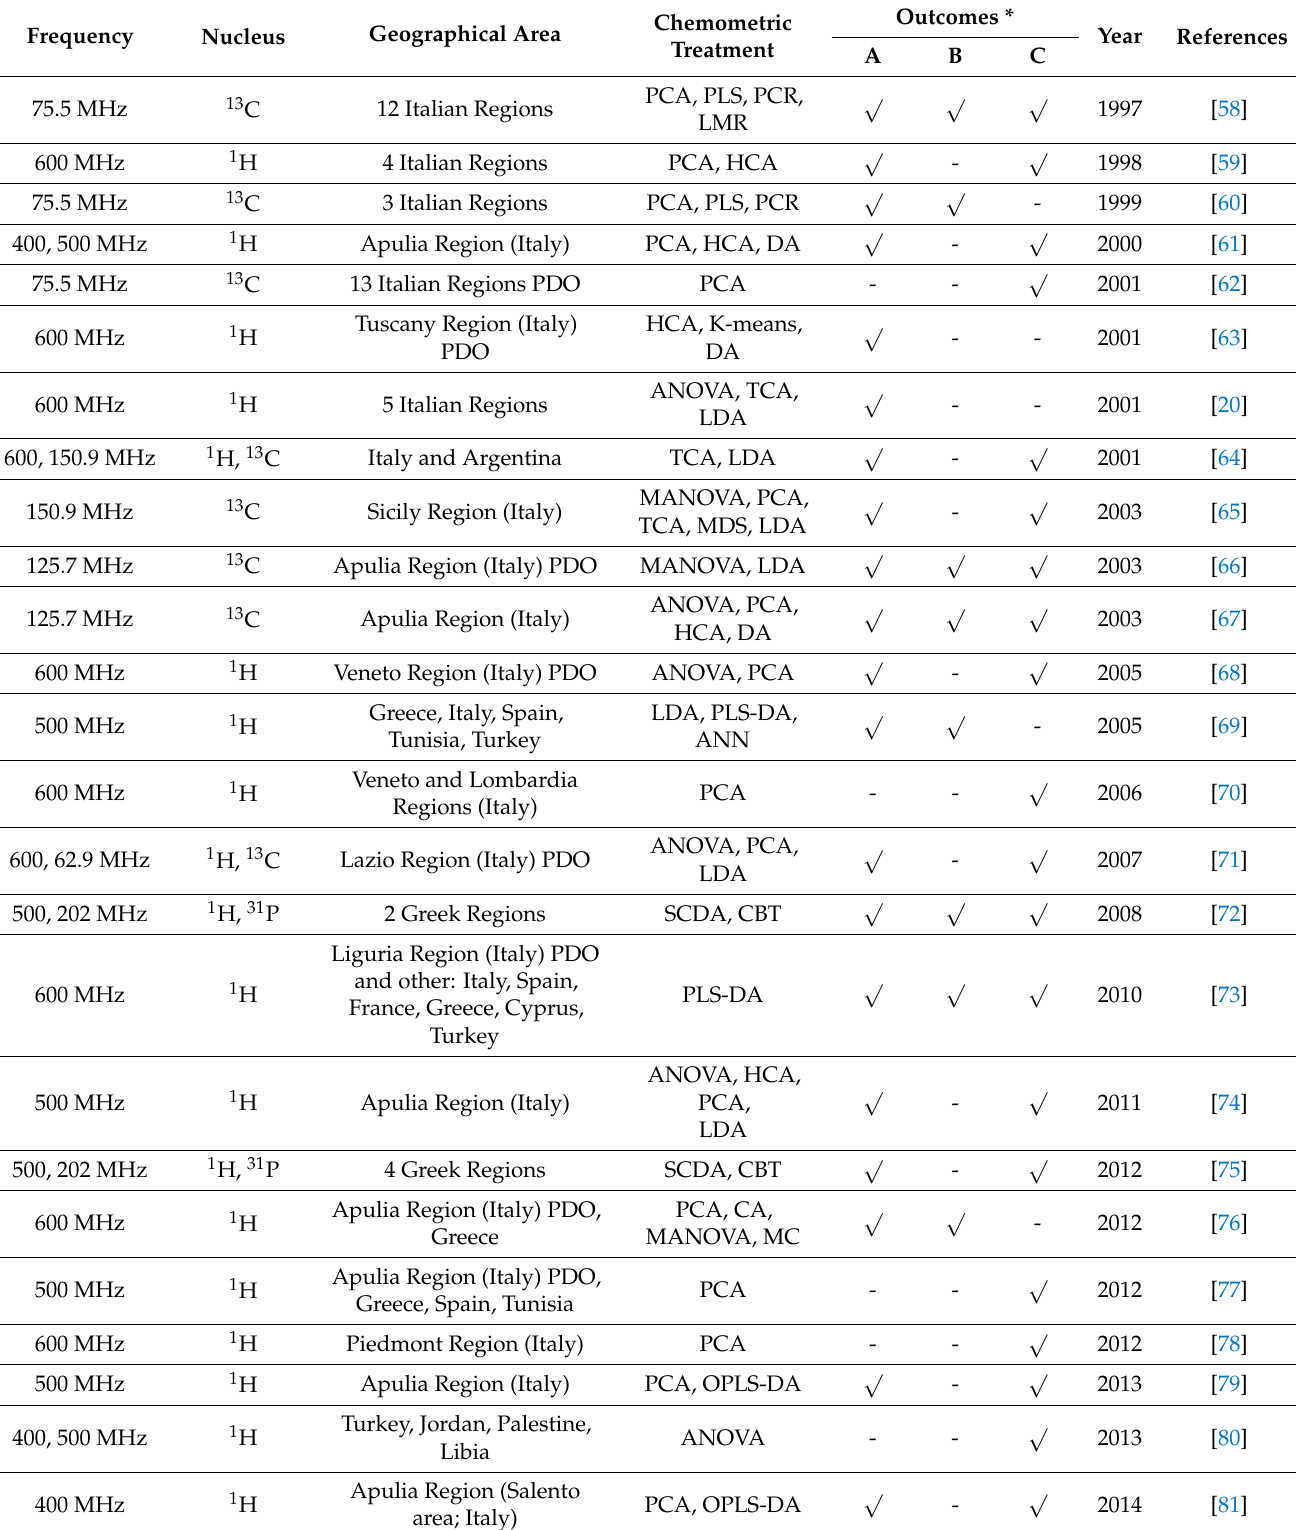
Table 2. Geographical classification studies of EVOOs by NMR spectroscopy, according to the chronological order of